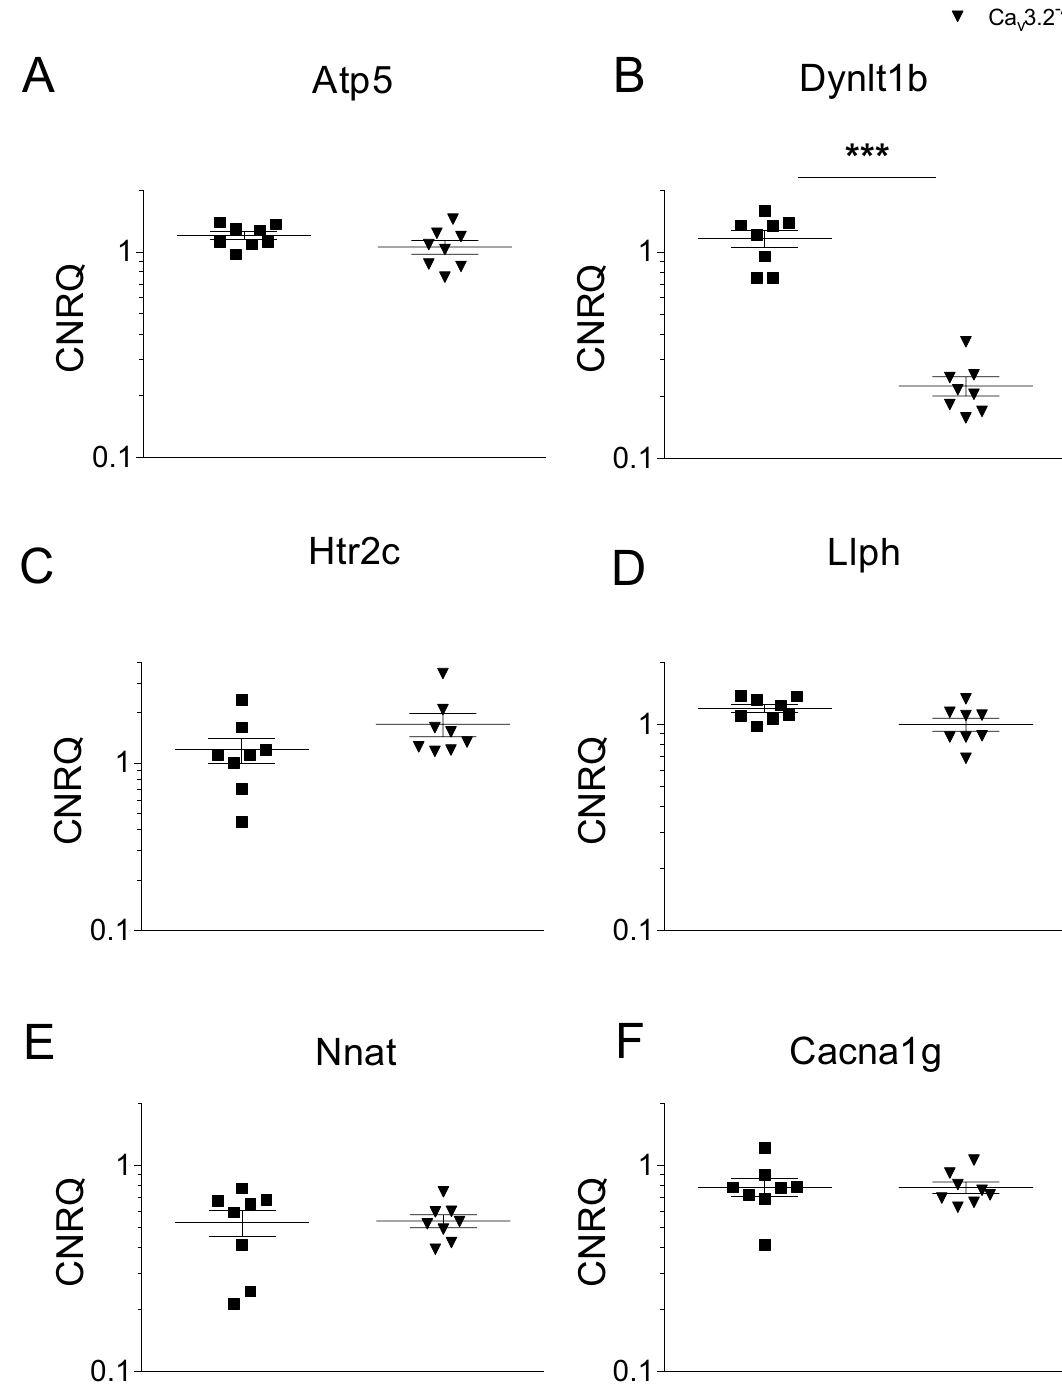
Figure 10. qPCR analysis of candidate genes obtained from hippocampal transcriptome data in Ca v 3.2 +/+ and Ca v 3.2 −/− mice. Hippocampal transcriptome experiments were carried out previously. The following